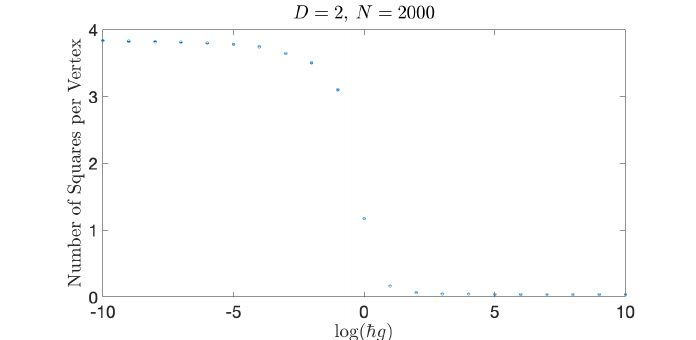
Figure 2 . Average number of squares per vertex as a function of the coupling constant g ~ (nor- malized to 1 at the transition) for D = 2 . The maximum value for a square lattice is 4.